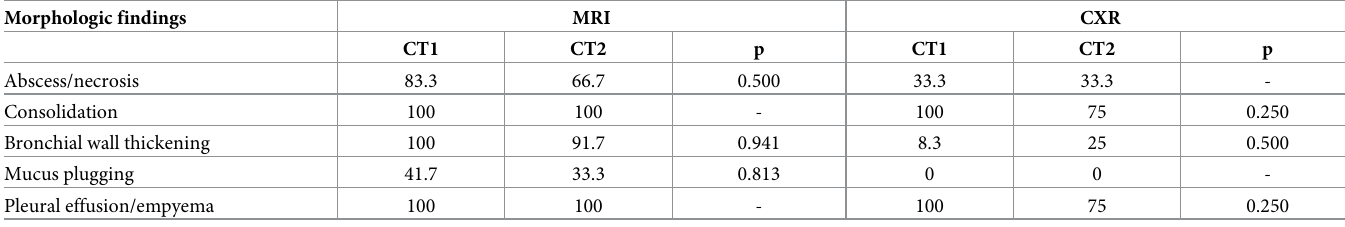
This indicates, that MRI allows better evaluation of the accompanying airways disease, which seems to be limited by means of CXR. Both morphological findings had the lowest intra- and